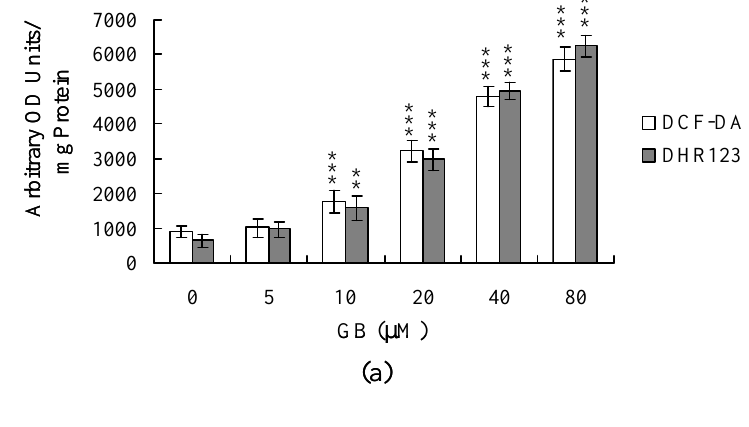
Figure 2. Ginkgolide B induces ROS generation in MCF-7 cells. Cells were incubated with 20 m M DCF-DA or 20 µ M dihydrorhodamine 123 (DHR 123) for 1 h, and treated with various concentrations of ginkgolide B (GB) for another 24 h. (A) ROS generation was assayed by DCF-DA or DHR 123 fluorescence, and expressed as absorbance/mg of protein; (B, C) Cells were pre-incubated with N-acetyl cysteine (NAC; 300 µ M) or α –tocopherol (Toc; 300 µ M) for 30 min and then treated with ginkgolide B (80 µ M) for another 24 h. ROS generation was assayed using DCF-DA or DHR 123 dye (B). Apoptosis was evaluated using the Cell Death Detection ELISA kit (C). The data are representative of eight independent experiments. **P<0.01 and *** P ＜ 0.001 versus the untreated control group. # P <0.001 versus the ginkgolide B-treated only